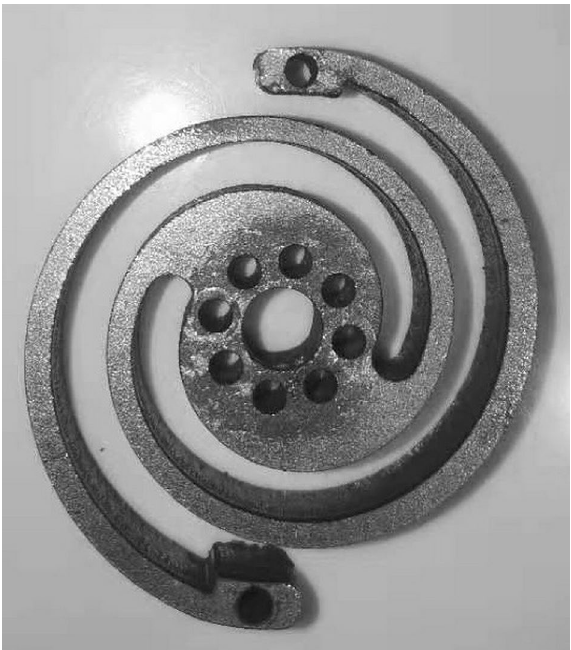
Figure 9. Manufactured planar spiral spring.